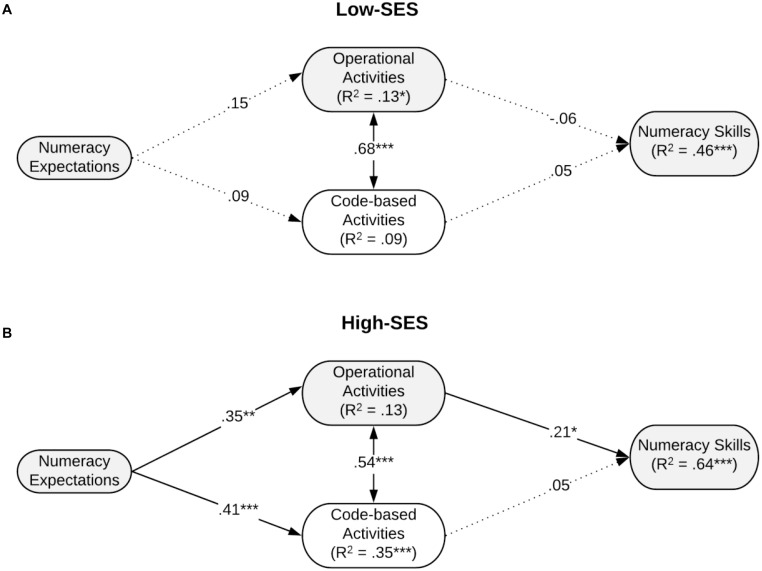
Final path model shows relations among numeracy expectations, home learning activities, and children’s outcome for low SES group (A: n = 99) and high SES group (B: n = 74) controlling for child’s age. The R2 values shown include variance predicted by the control measure. The numbers on the arrows are the standardized coefficients. Dashed lines present no significant paths. *p < 0.05, **p < 0.01, and ***p < 0.001.